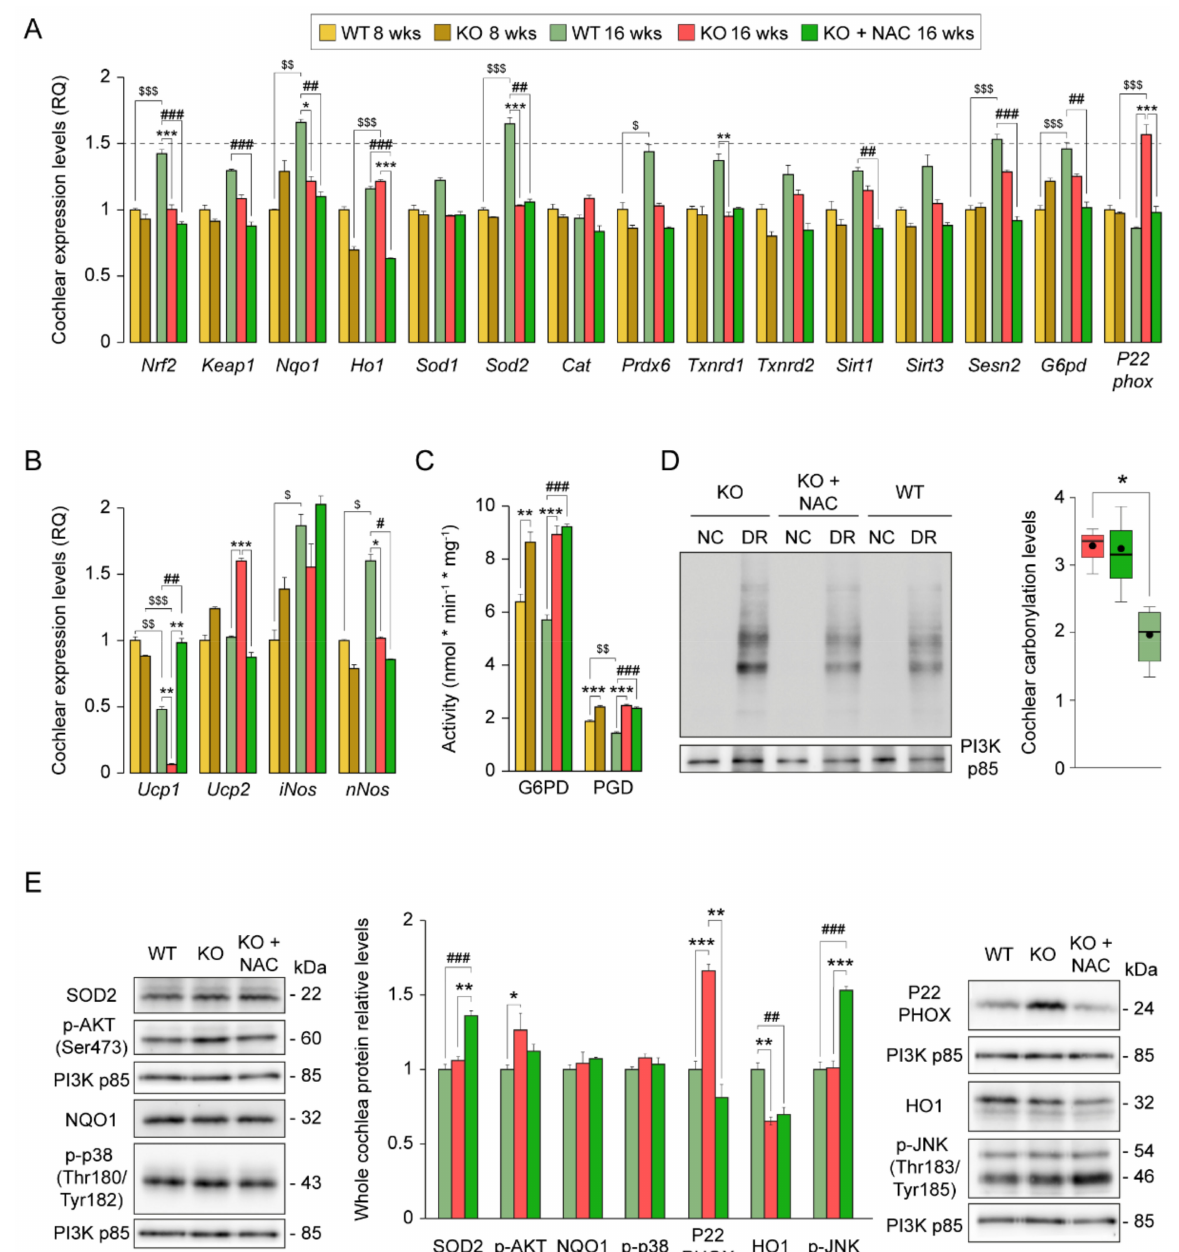
Figure 4. Impact of N-acetylcysteine administration for cochlear redox homeostasis. ( A , B ) RT-qPCR gene expression levels of redox enzymes from whole cochlea pooled samples from 3 mice per condition. Expression levels were calculated as 2 − ∆∆ Ct (RQ) from triplicate measurements using Hprt1 as a reference gene and normalized to levels in 8-week-old wild-type (WT) mice. Data are presented as mean ± SEM. ( C ) Glucose-6-phosphate dehydrogenase (G6PD) and 6-phosphogluconate dehydrogenase (PGD) activity from pooled inner ear cytosolic fractions of two mice per condition. Measurements were performed in triplicate, and values are presented relative to milligram of protein. Data are presented as mean ± SEM. ( D ) Cochlear oxidative protein carbonylation levels of pooled cochlear protein extracts from 3 mice per condition analyzed with the Oxyblot™ Kit. Derivatized protein extracts (DR) are shown together with non-derivatized extracts (NC) in the representative blot image. Quantification was performed in triplicate, and levels were referred to those of PI3K. Data are presented as a box plot, mean value is plotted as a filled circle and whiskers represent min and max values. ( E ) Western blotting of pooled cochlear protein extracts from 3 mice per condition. All protein levels are referred to those of PI3K and normalized to data from 16-week-old WT mice. Data are presented as mean ± SEM. Statistical significance between genotypes and time points was analyzed by one-way ANOVA: * vs. KO, # vs. WT, $ 8-week-old mice vs. 16-week-old mice (*, #, $ p < 0.05; **, ##, $$ p < 0.01; ***, ###, $$$ p <